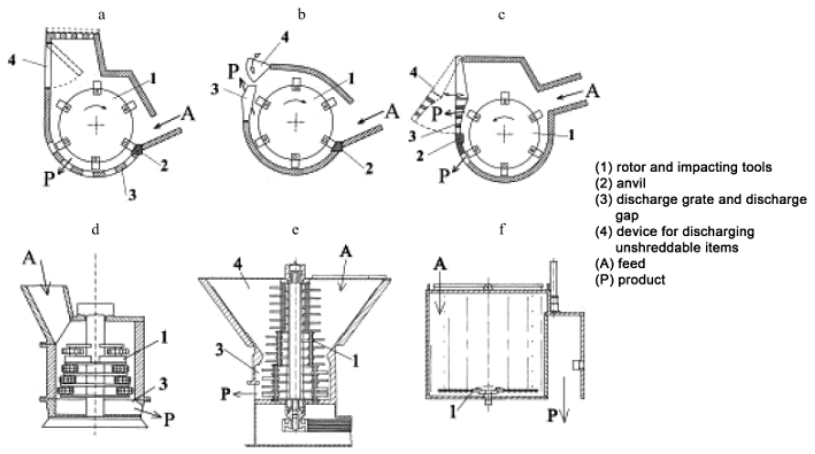
Figure 6. Types of swing-hammer shredders: ( a – c ) horizontal and ( d – f ) vertical shaft shredders. Reproduced with permission from [32], John Wiley and Sons,